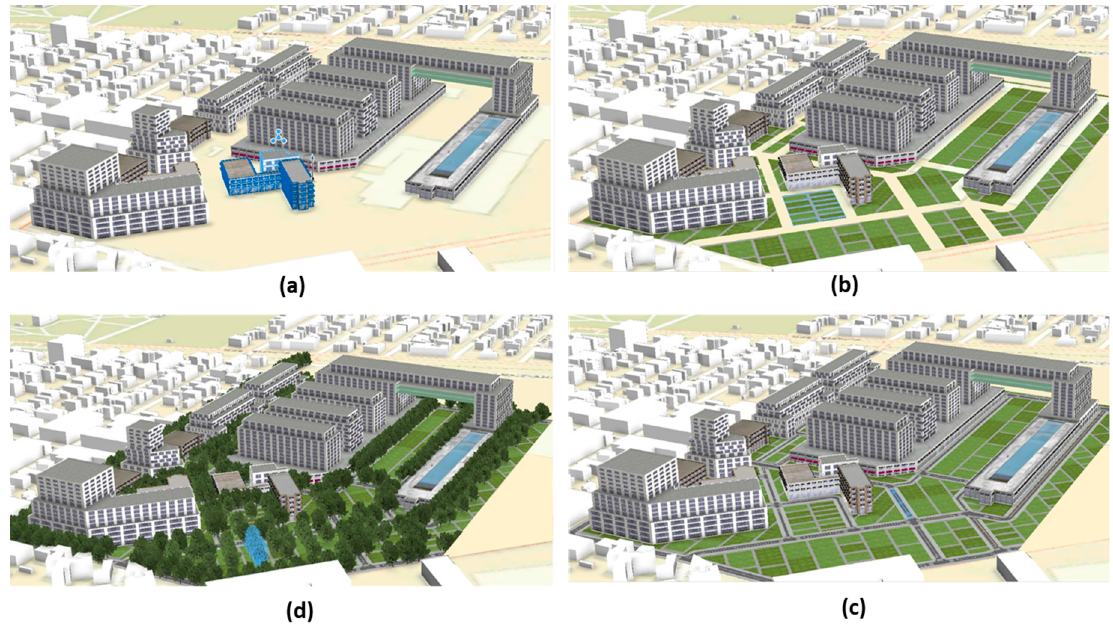
Figure 5. The process of Dominion Bridge modeling through ArcGIS CityEngine: ( a ) The textured 3D building modeling; ( b ) the landcover modeling (landscape + internal pathways): ( c ) the pathway modeling: ( d ) the realistic (LoD3) 3D tree modeling using the 3D Norway maple tree model in ArcGIS CityEngine.